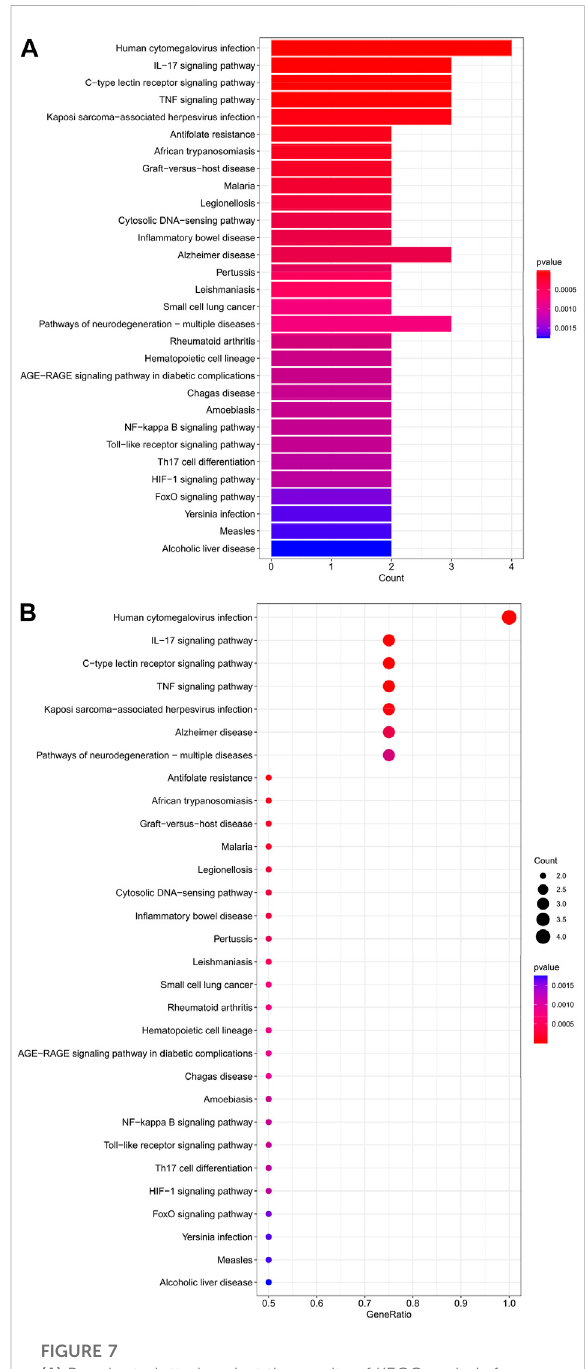
FIGURE 7 (A) Bar chart plotted against the results of KEGG analysis for the Hub gene, (B) Bubble chart plotted against the results of KEGG analysis for the Hub